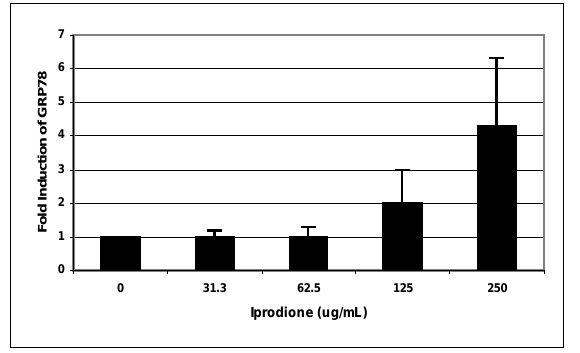
Fig. 10: Fold induction of GRP78 in HepG